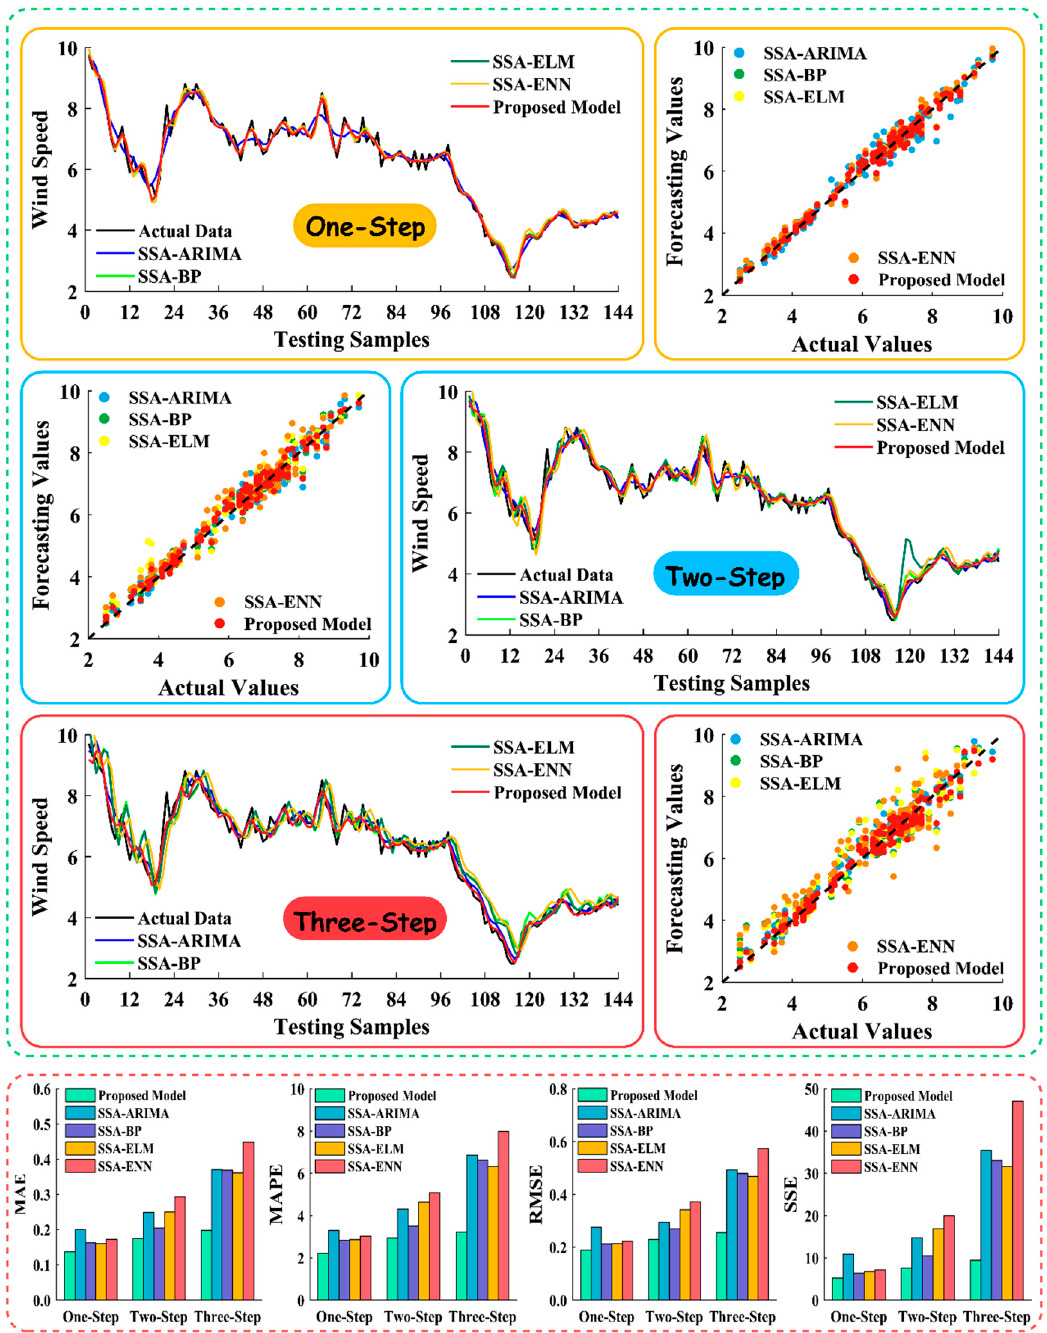
Figure 3. Comparison of experiment 1 results in site 1.